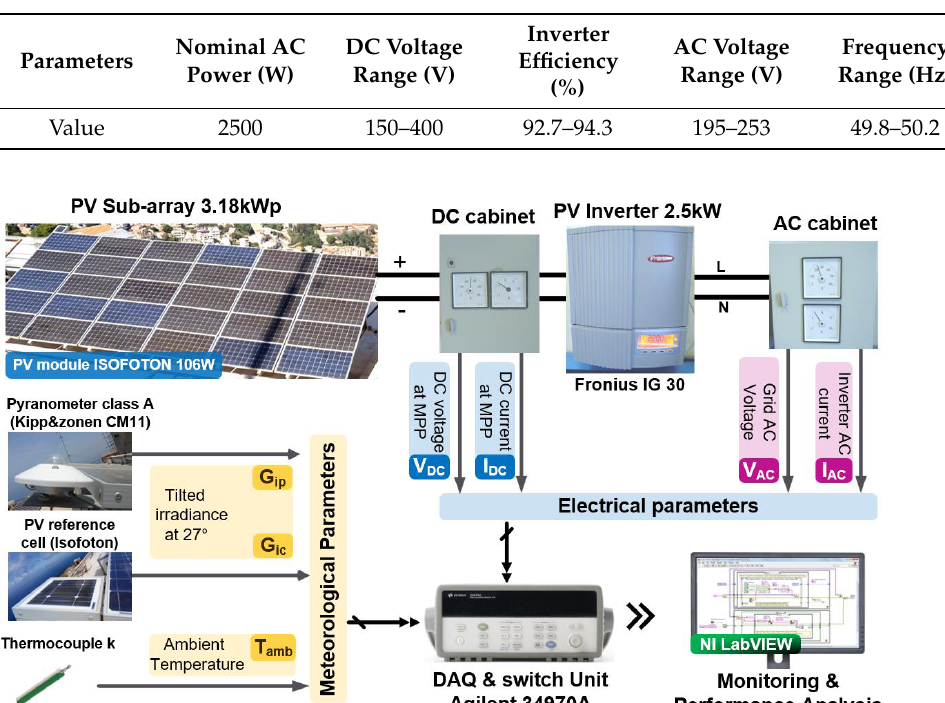
Table 2. Electrical Characteristic of PV Inverter Fronius IG 30 under nominal conditions.